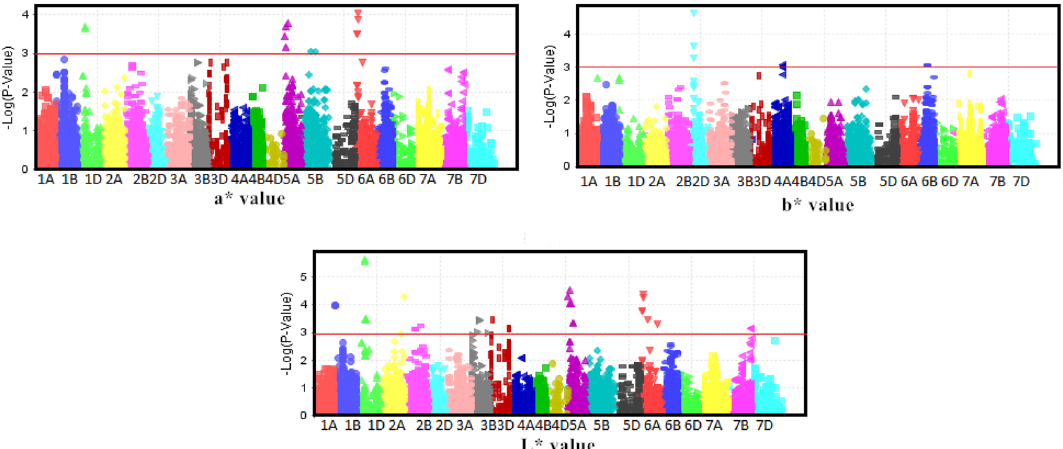
Figure 2. Manhattan plot of the L* value and the a* value of fresh dough sheet and the b* value of dry dough